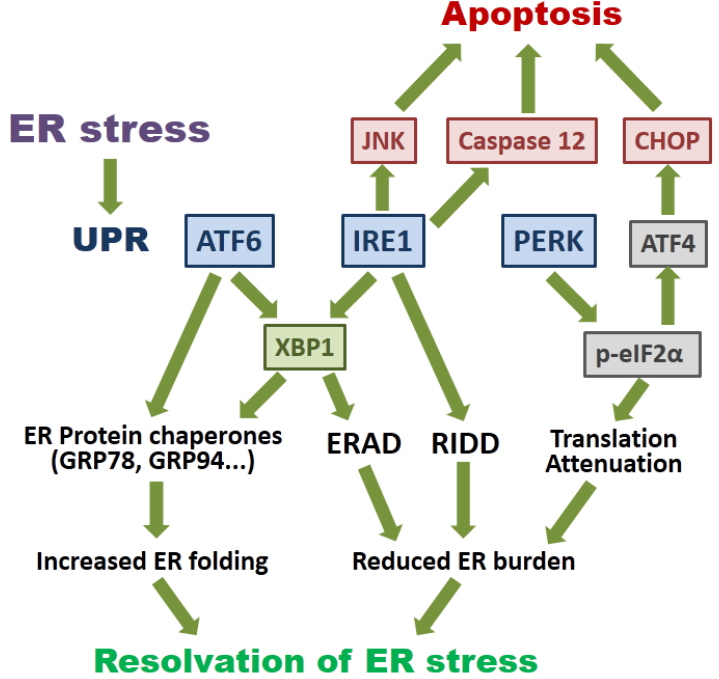
Figure 1. Signaling pathways of the endoplasmic reticulum (ER) stress response. ER stress induces the activation of unfolded protein response (UPR). Transcriptional activation of the transcriptional factor-6 (ATF6) induces X-box protein 1 (XBP1) and ER protein chaperones